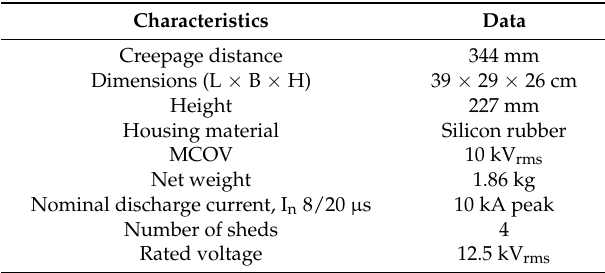
Table 1. Dimensions and parameters of the surge